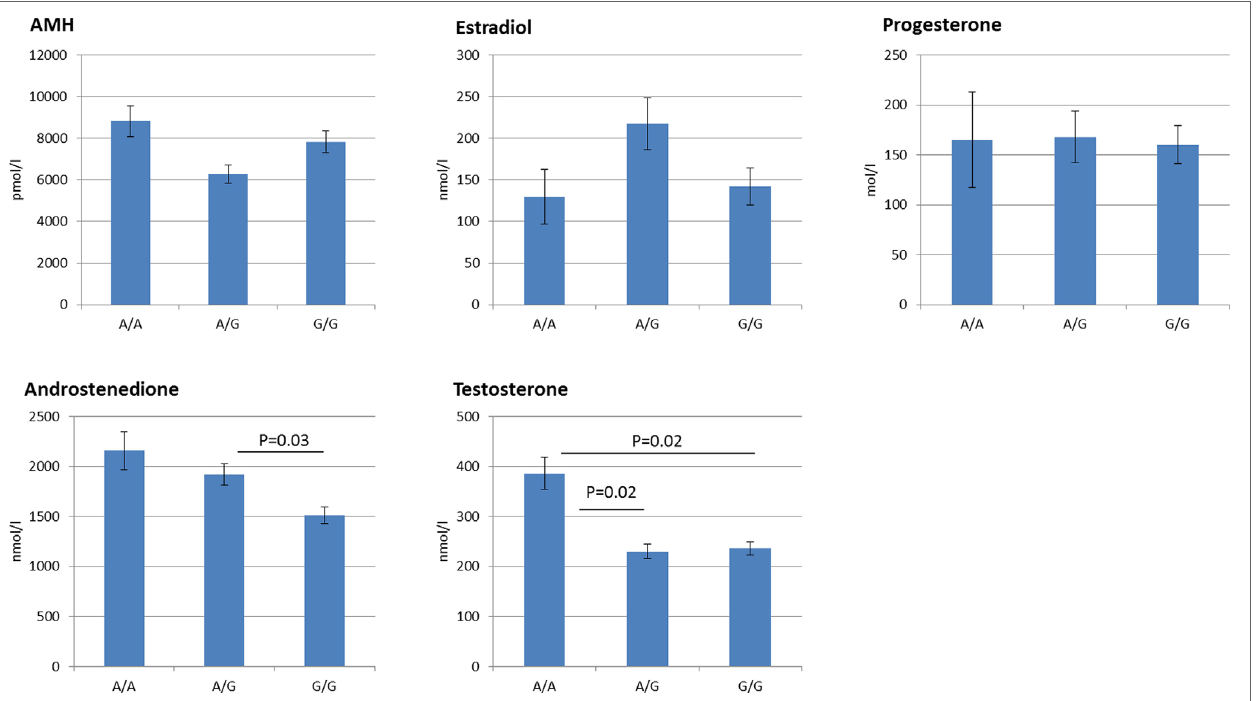
FigUre 1 | Follicular fluid hormone profiles grouped according to follicle stimulating hormone receptor − 29G > A genotype. The figure displays the Mean ± SEM of the intrafollicular hormone levels. Statistically significant differences in hormone levels are observed for androstenedione, and testosterone. In addition, discrete genotype-dependent differences are observed for Anti-Müllerian hormone and estradiol in an inverse manner, although not statistically